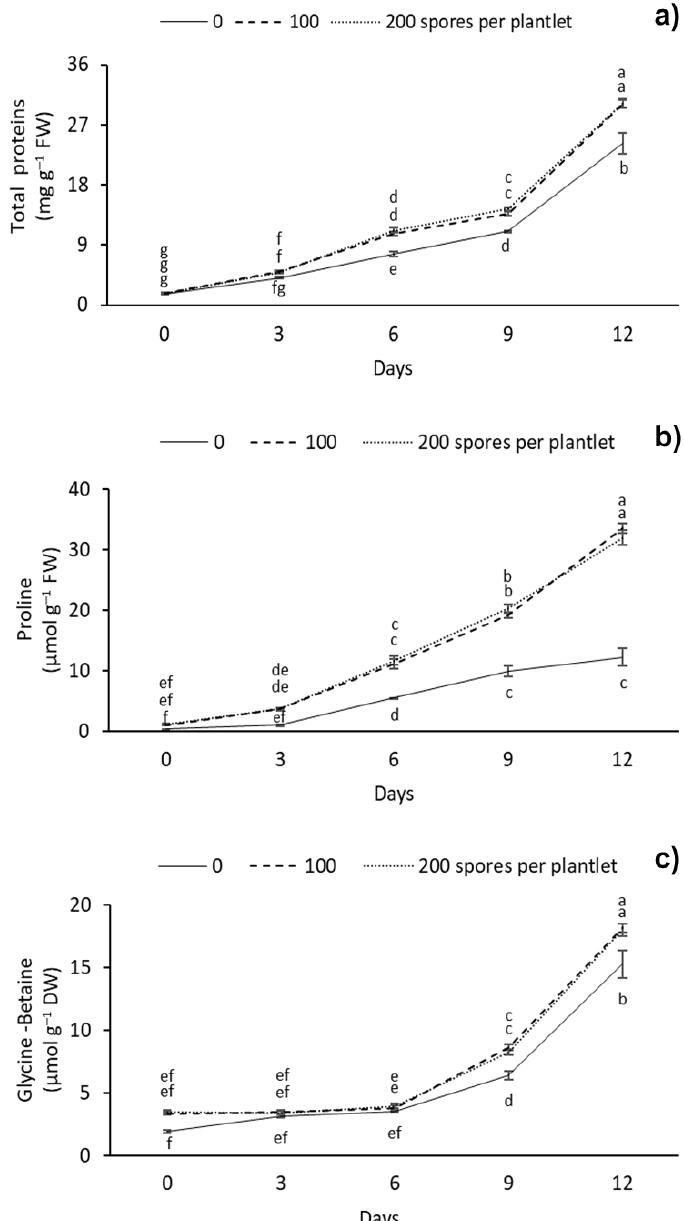
Figure 5. Effect of different doses (0, 100, and 200 spores per plantlet) of arbuscular mycorrhizal fungi ( Glomus intraradices ) on sugarcane plantlets ( Saccharum spp. cv Mex 69-290) evaluated under drought stress during acclimatization stage. ( a ) Total protein, ( b ) proline and ( c ) glycine-betaine. Results are shown as mean ± standard error. Means with different letters (a–f) are significantly different (Tukey, p < 0.05).